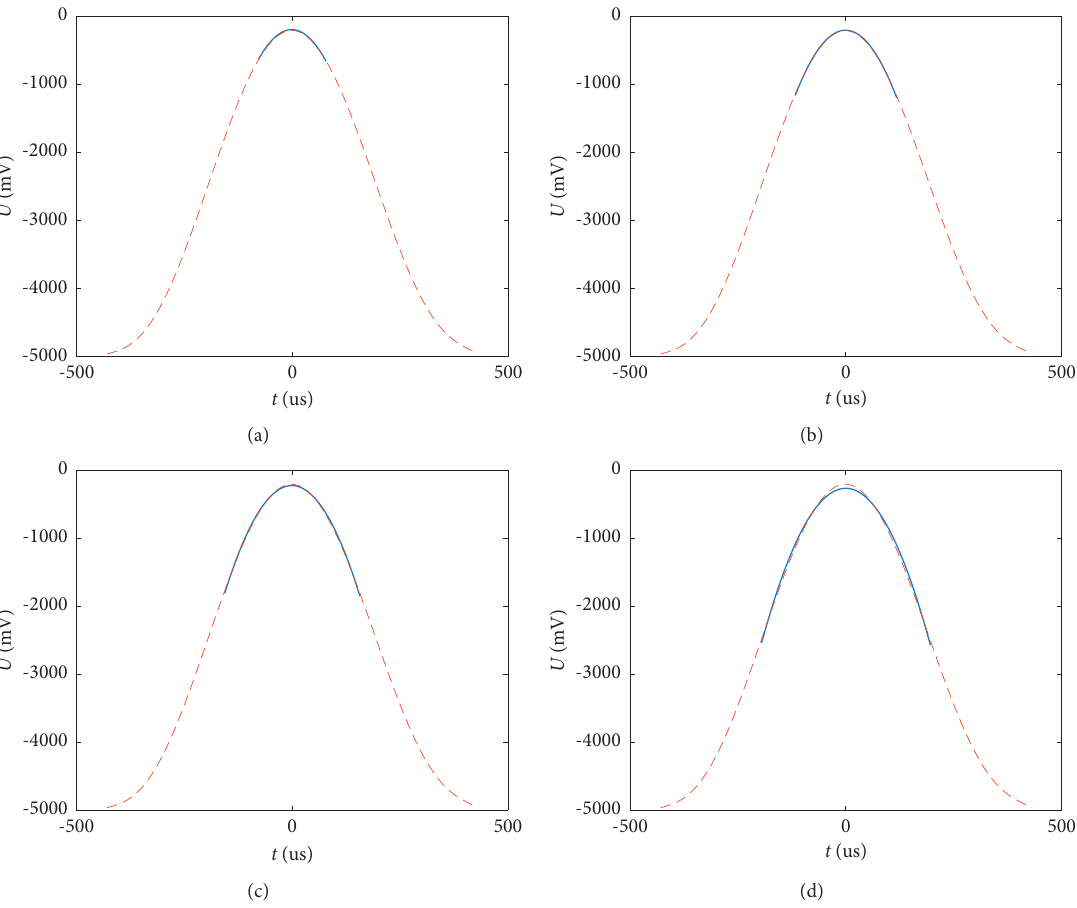
Figure 9: Experimental data fitting curves and the quadratic fitting curves of different interception ranges. (a) 20%. (b) 30%. (c) 40%. (d) 50%.